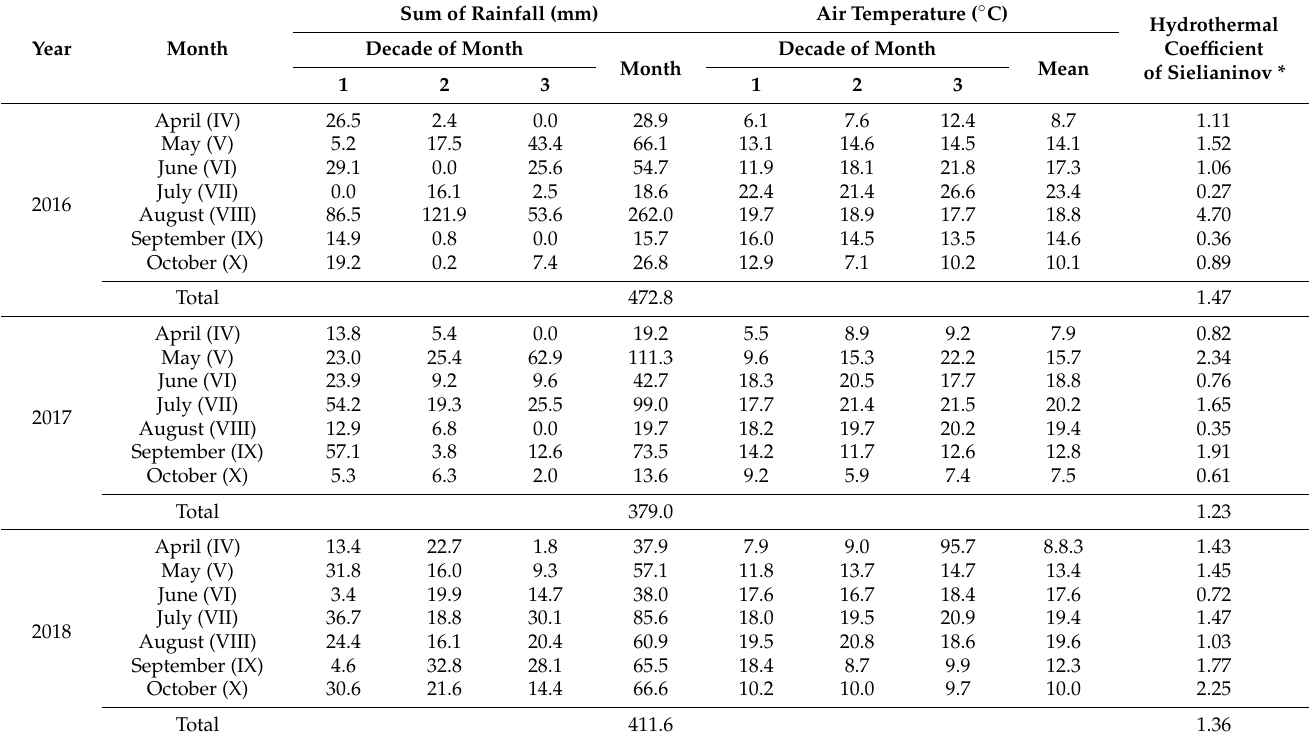
Table 4. Rainfall, air temperature and hydrothermal coefficients of Sielianinov during the growing season of JA according to the data from the meteorological station in Uhnin for 2016–2018. Sum of Rainfall